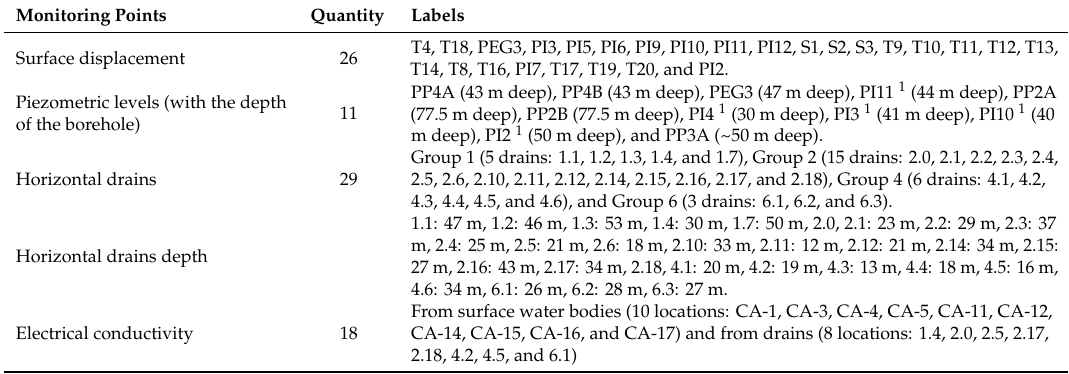
Table 1. Instrumentation in the Guarumales landslide used in this